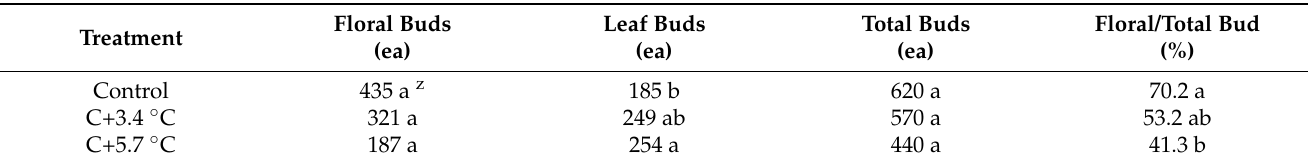
Table 4. The number of flowers and leaf buds of ‘Mihong’ peaches affected by elevated temperatures under a carbon dioxide concentration of 700 µ mol · mol − 1 .